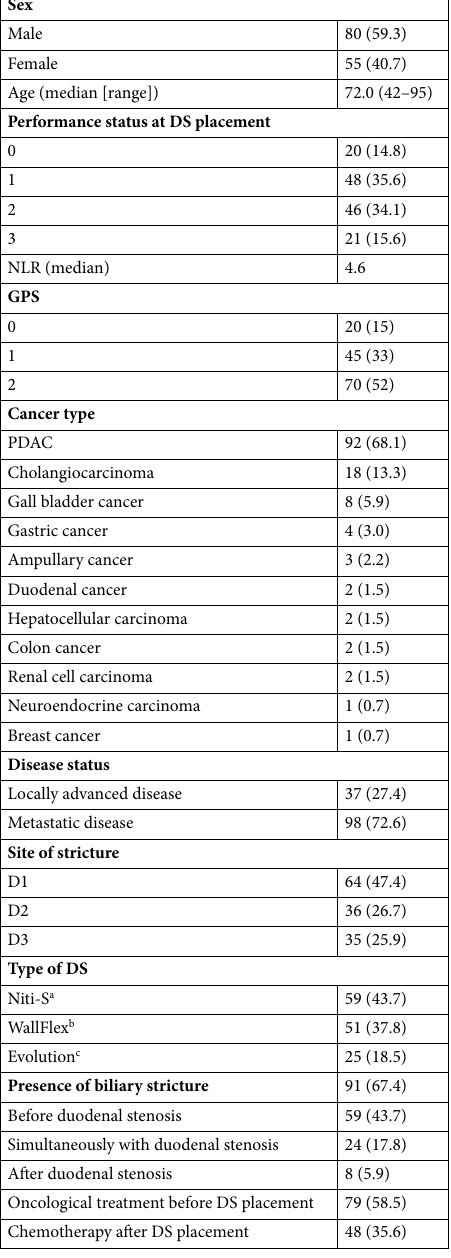
Table 1. Characteristics of enrolled patients. Categorical data are presented as number (percent), continuous data as median (range). DS duodenal stent, GPS Glasgow Prognostic Score, NLR neutrophil-to-lymphocyte ratio, PDAC pancreatic ductal adenocarcinoma. a Taewoong Medical, Seoul, Korea. b Boston Scientific, Marlborough, MA, United States. c Cook Medical, Winston-Salem, NC, United